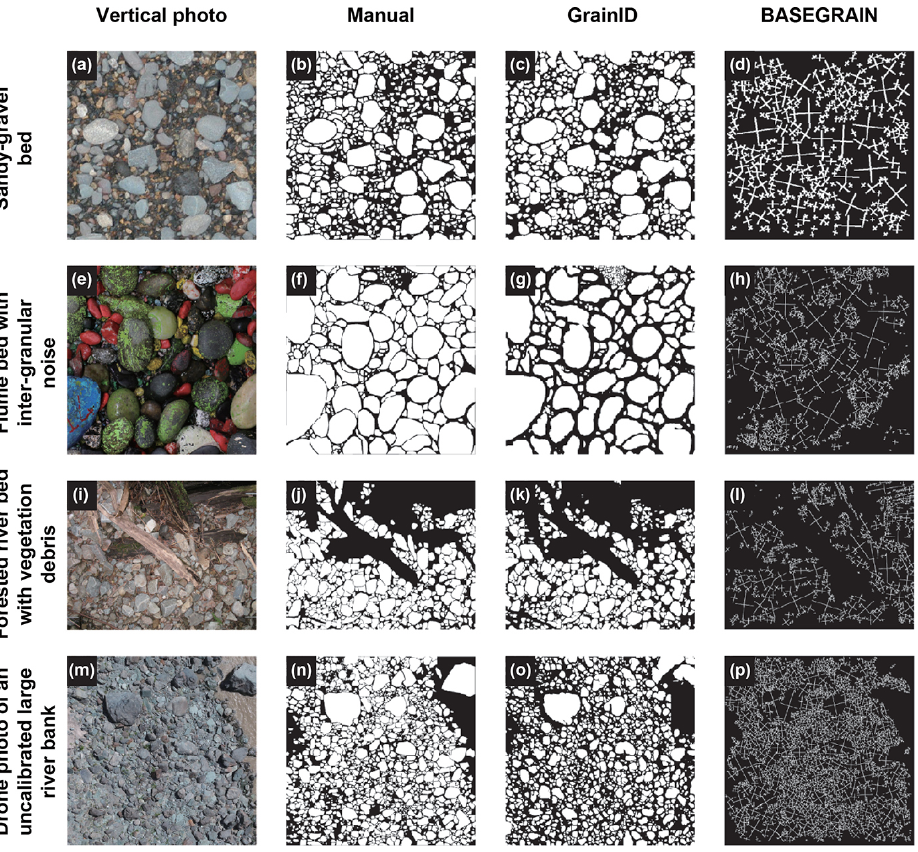
Figure 5. Vertical photos and predicting results of manual labeling, GrainID and BASEGRAIN for a variety of environments: (a–d) flume sandy-gravel bed (SAFL dataset); (e–h) flume gravel bed with inter-granular noise (MCHEL dataset); (i–l) location with dense vegetation (Sullivan Creek); and (m–p) drone photo of an uncalibrated large river bank (Yangtze